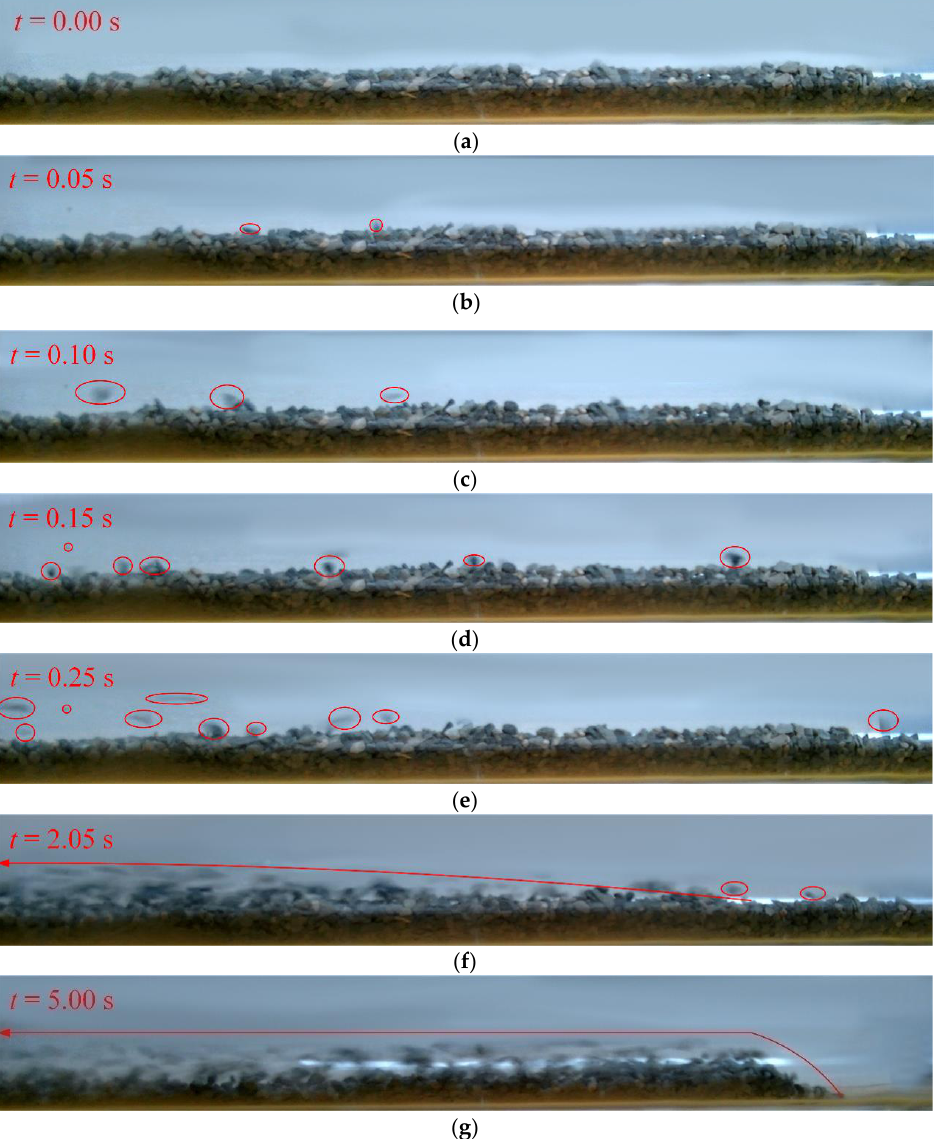
Figure 8. Pick-up process of pebble particles. ( a ) t = 0.00 s, ( b ) t = 0.05 s, ( c ) t = 0.10 s, ( d ) t = 0.15 s, ( e ) t = 0.25 s, ( f ) t = 2.05 s, ( g ) t = 5.00 s. Figure 8 depicts that particle-picking starts with a few particles rolling and impacting other particles, and the particles at the end of the pipeline are picked up gradually and sus- pended. When the particles are reduced to a certain number, the particles move in the form of laminar flow. The picking process can be divided into four stages. First, particles begin to roll along the particle layer (Figure 8b). Second, the picked particles collide with other particles in the layer (Figure 8c – e), and the particles begin to rebound. Third, the newly picked particles collide with the particles already carrying air (Figure 8f). Fourth, the windward side of the particle group is picked up gradually, and the particle-picking process ends. It can be seen from Figure 8c – f that as few particles are picked up, the picked-up particles roll and jump, thereby impacting the deposited particles, and these particles are picked up (as shown in Figure 8c – e). The picked-up particles impact other particles in the rolling process, causing the particles on the surface of the particle group to be picked up gradually. The pick- ing process of the particle group gradually slows down with cutting, as shown in Figure 8f. With the picking process, the number of particles deposited at the bottom gradually decreases, and the friction between the particles and the wall decreases. When the fluid force on the windward side of the particles exceeds the friction of the particle pile, the particles move along the outlet in the form of laminar flow, as shown in Figure 8g. Some randomness exists in the particle-picking process; thus, the particle-picking re- gimes will appear in a limited range of airflow velocity only. Therefore, the pickup veloc- ity of the particles determined by visual observation will lead to a certain error, and a reasonable pickup velocity is a key to the research on the process of particle-picking in horizontal pipes; some researchers had a different definition of pickup velocity in the past. To solve the problem of micro-particle dune flow, Hayden et al. [26] slanted the material